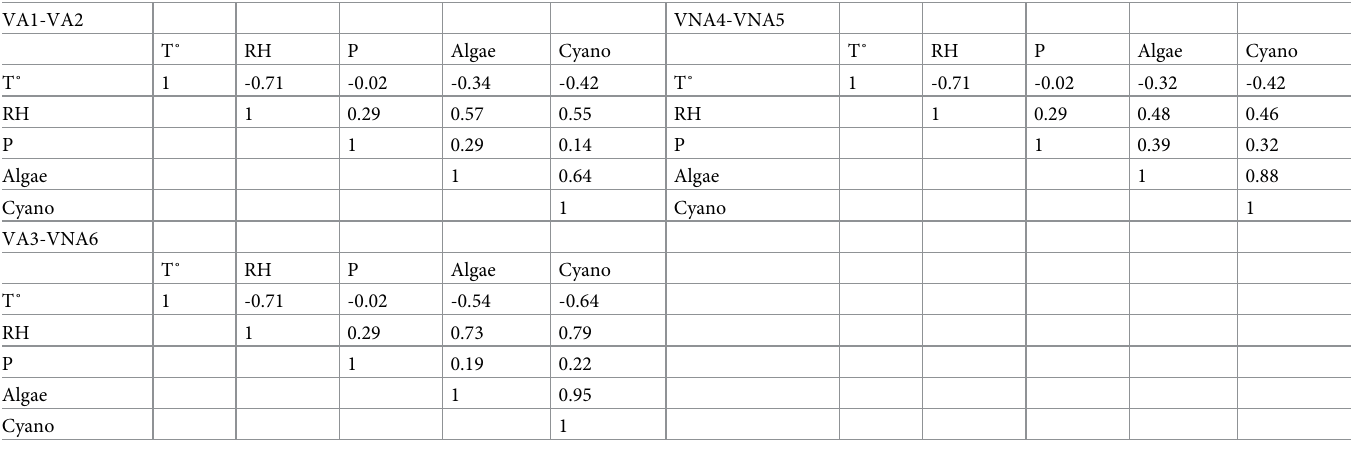
Pearson correlation matrices (Table 5) were calculated between different independent meteo- rological parameters (daily mean temperature, daily mean relative humidity, daily cumulative rainfall) and green algae and cyanobacteria daily concentrations for vertical positions to deter- mine which factors control the presence of algae and cyanobacteria. Results show that there is a good correlation between algae and cyanobacteria concentrations, which highlights that they have a similar evolution and relatively similar values. Concerning meteorological parameters, there is a good correlation of algae and cyanobacteria concentration with RH, especially for VA3, VNA6 that are the locations that remain the wettest. The correlation with rainfall is posi- tive but less significant. On the contrary, the correlation with temperature is negative. Table 5. Pearson correlation matrix realized on 6 samples of different meteorological parameters and benthic microorganisms concentration in vertical positions.